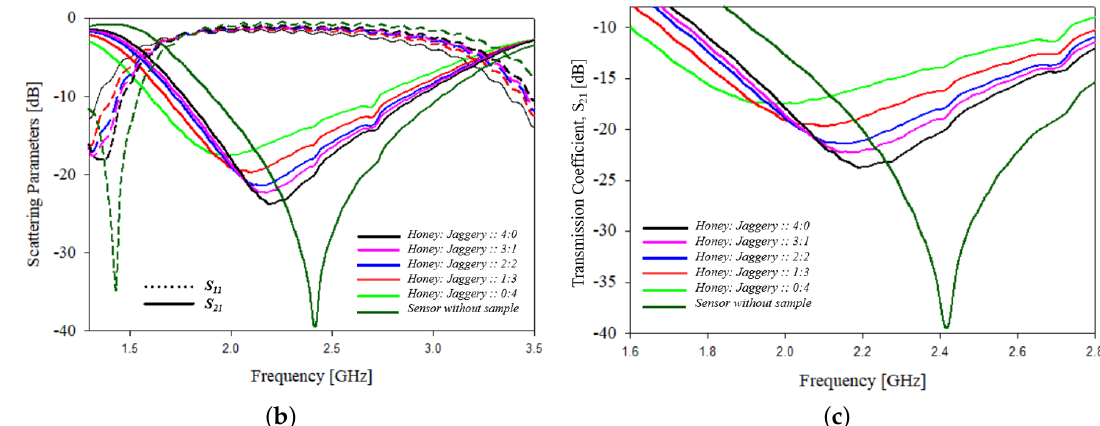
Figure 29. Adulteration testing in honey: ( a ) experimental setup, ( b ) variation in the scattering parameters with frequency and ( c ) variation in transmission coefficient parameters with frequency.